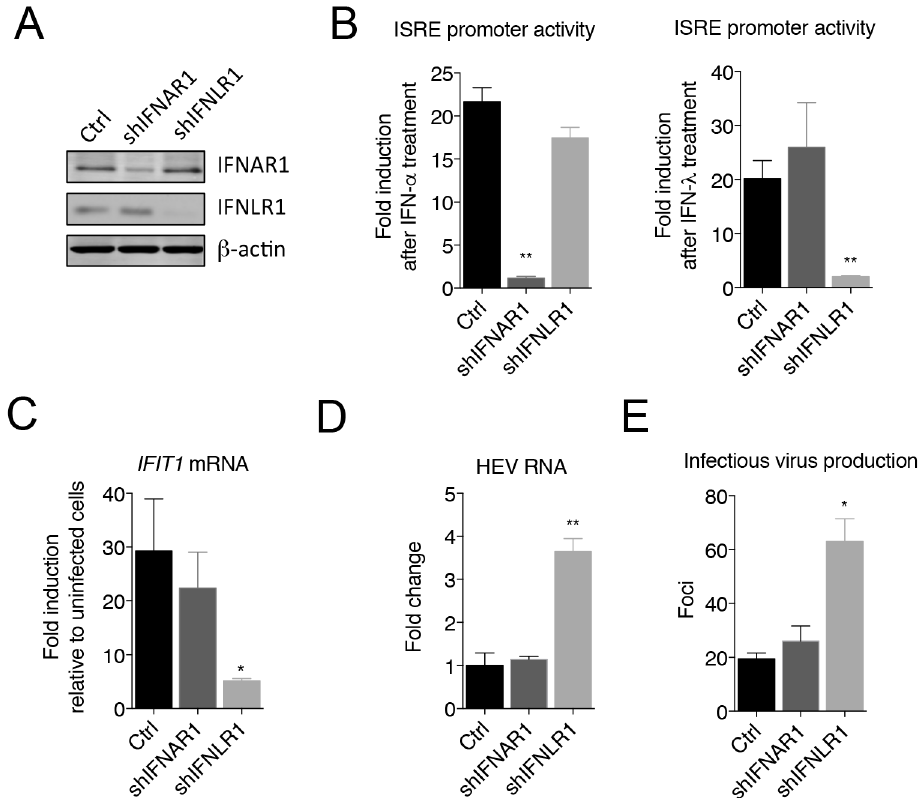
Fig 2. Type III IFN response regulates HEV replication. (A) Immunoblotsof IFNAR1, IFNLR1 and β -actin in HepG2 cells transduced with lentiviruses expressinggene-specific shRNA or GFP (Ctrl). (B) ISRE promoteractivity in different cells after IFN- α or IFN- λ treatment. HepG2 cells were transfected with an interferon-sensitive responseelement(ISRE) promoter-driven firefly luciferasereporter plasmidISRE-Luc and a herpessimplex virus thymidinekinase promoter-driven Renillaluciferase(TK-RLuc) plasmidfor 24 h, then treated with IFN- α (100ng/ml) or IFN- λ 1 (220ng/ml)for 24 h. Data are expressedas fold changesrelative to non-treated cells basedon the relative luciferase activities (firefly luciferase vs. Renillaluciferase). Shown are representative results (mean ± SEM) from two independentexperiments each performed in triplicate. (C-E) Effects of IFN receptorknockdown on ISG expression and HEV replication.HepG2 cells transduced with lentiviruses expressinggene-specific shRNA or GFP (Ctrl) were infected with HEV for 5 days. ( C ) Intracellular IFIT1 mRNA expressiondetermined by qRT-PCR. Results are represented as fold changes relativeto HEV-infected control cells. ( D ) HEV RNA abundance determined by qRT-PCR (fold changes relativeto HEV-infected control cells). ( E ) Cells expressingdifferent shRNA or GFP (Ctrl) were infected with HEV for 5 days, harvested and subjectedto three rounds of freeze-thaws prior to inoculation to na ï veHepG2 cells. Infected cells were detected by IFA and HEV foci were countedafter 5 days. Each data point represents the mean ± SEM of at least 2 independentexperiments in duplicateeach. * P < 0.05; ** P <